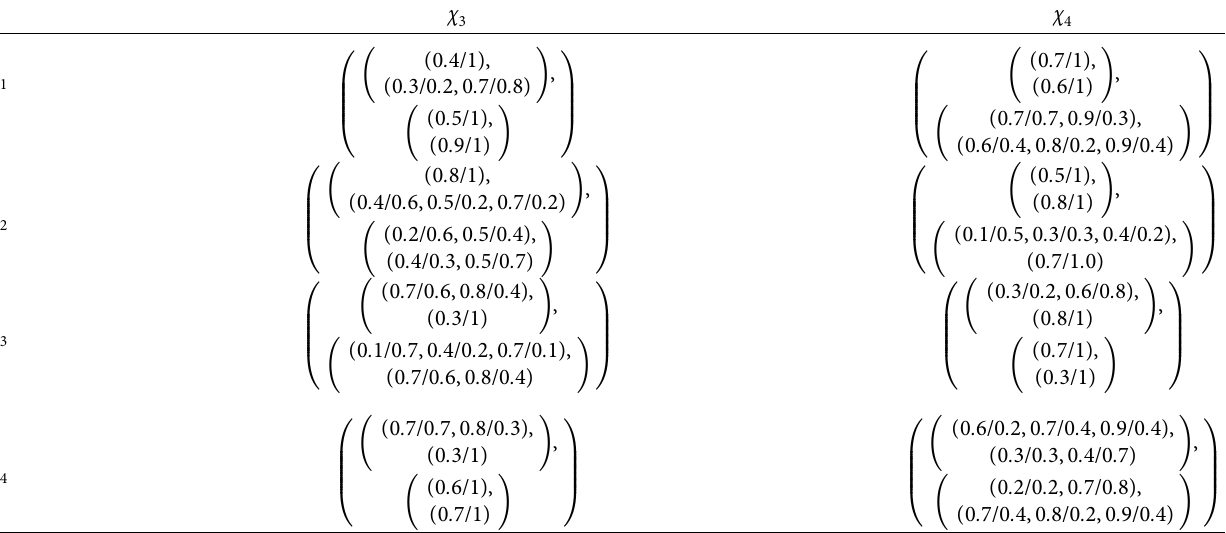
Table 10: Updated expert information.